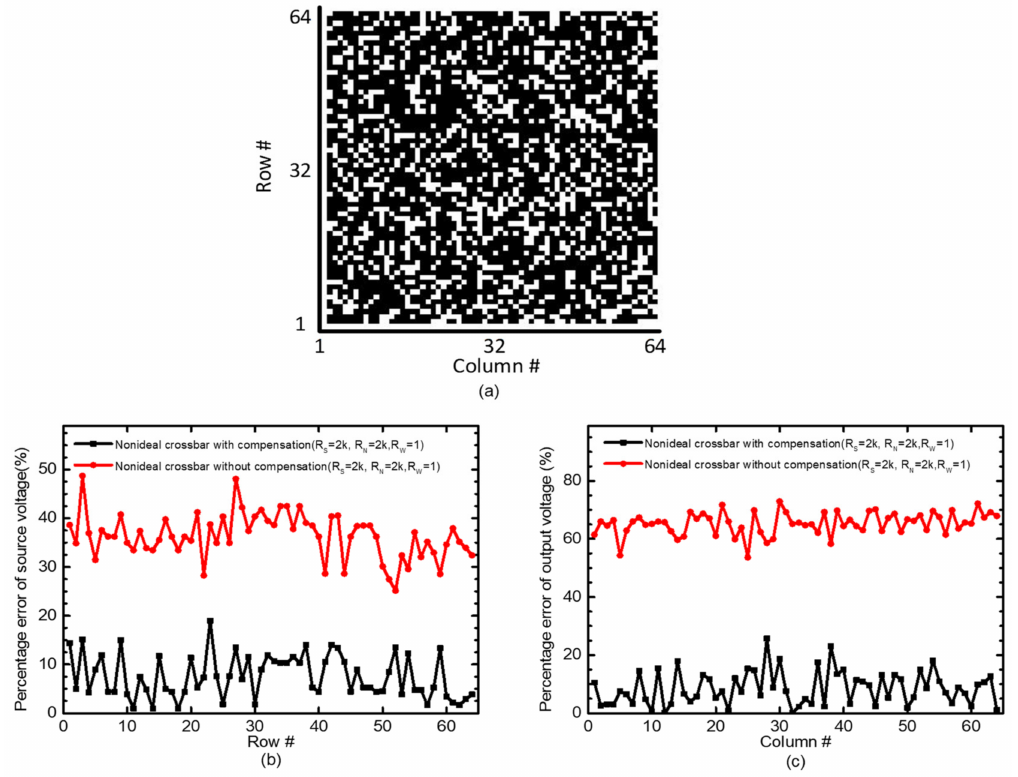
Figure 5. ( a ) Memristor crossbar with 64 rows and 64 columns. Here the white and black pixels represent LRS and HRS, respectively. ( b ) The percentage error of source voltage from Row #1 to Row #64. Here R S = 2 k Ω , R N = 2 k Ω , and R W = 1 Ω . The percentage error between the ideal and nonideal without the correction circuit is shown in the red line. The percentage error with the correction is shown in the black line. ( c ) The percentage error of output voltage from Column #1 to Column